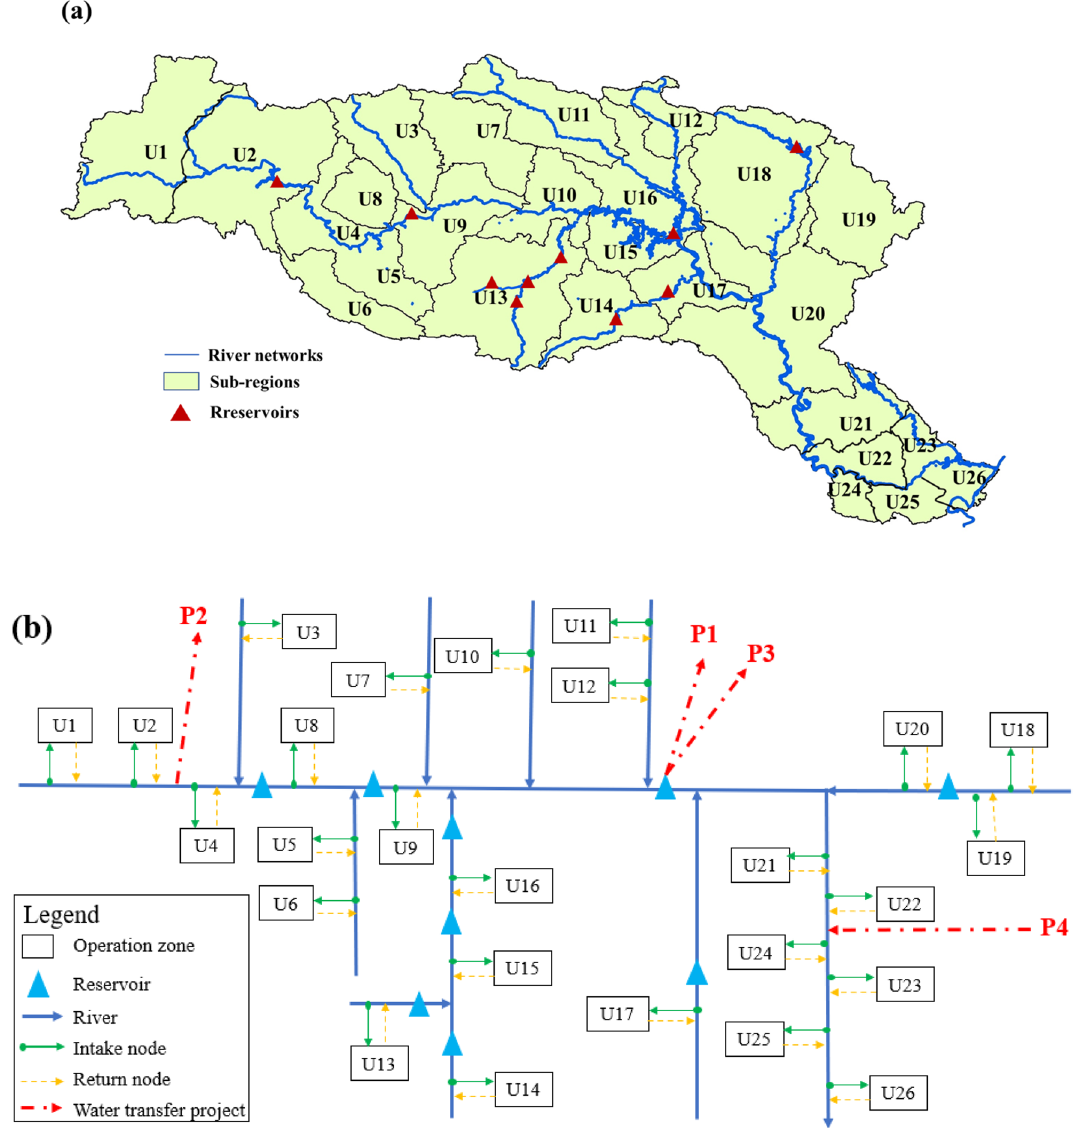
Figure 3. Map of the water supply system in the Han River basin: ( a ) sub-regions in the Han River basin [( a ) is generated by ArcGIS10.2 software. URL link: http:// www. arcgi sonli ne. cn/]; and ( b ) schematic diagram of the Han River basin. [( b ) is generated by Visio2016 software. URL link: https:// www. micro soft. com/ zh- cn/ downl oad/ detai ls. aspx? id=